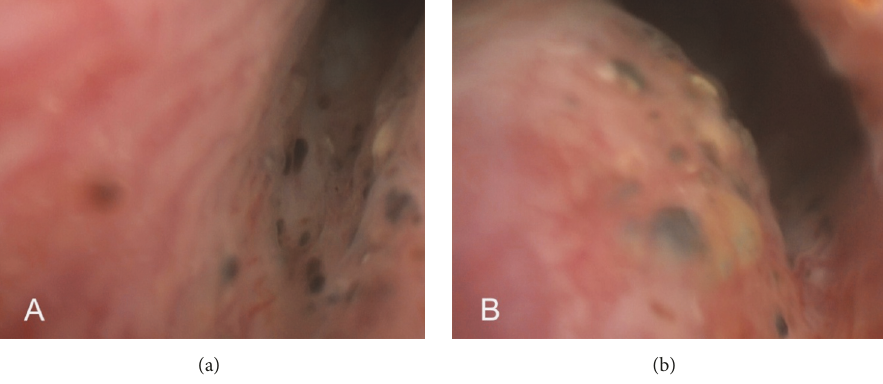
Figure 3: Endoscopic aspect of the prostatic urethra.